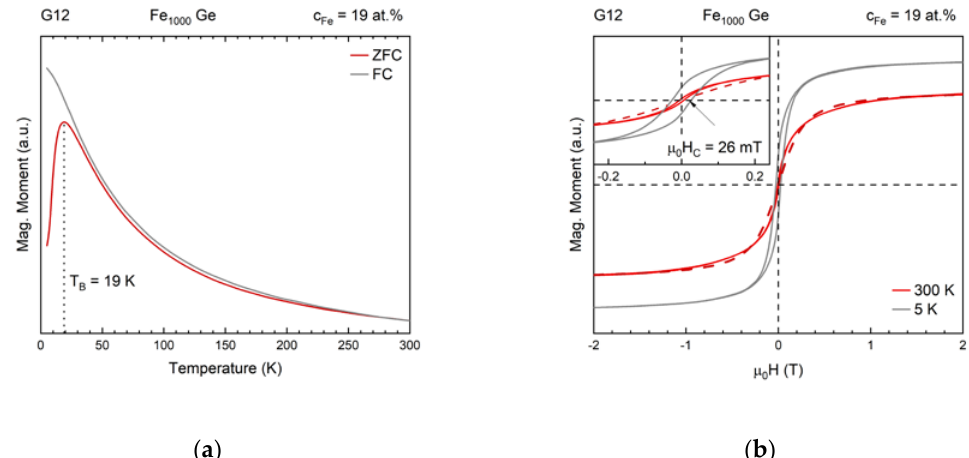
Figure 9. Magnetization measurements of sample G12. ( a ) ZFC/FC data plot reveals a maximum ZFC magnetization at 19 K. ( b ) Magnetization curves at 300 K and 5 K. Inset: The latter temperature reveals the film’s blocked (ferromagnetic) state due to a hysteresis in magnetization while the former reveals an anhysteretic dependence as expected in the superparamagnetic temperature range. The dashed line is a Langevin function that approximates the magnetization curve at 300 K. The appearance of a maximum in magnetization in the ZFC curve and a coincidence of ZFC and FC curve above the maximum together with the lack of hysteresis at room temperature are evidence for the existence of a superparamagnetic state and, hence, individual, separated clusters in the film.